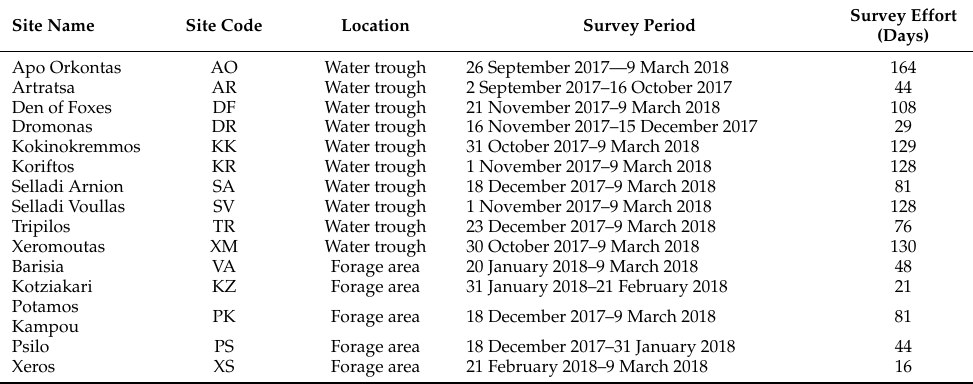
Table 1. Camera trapping survey period and effort per monitored